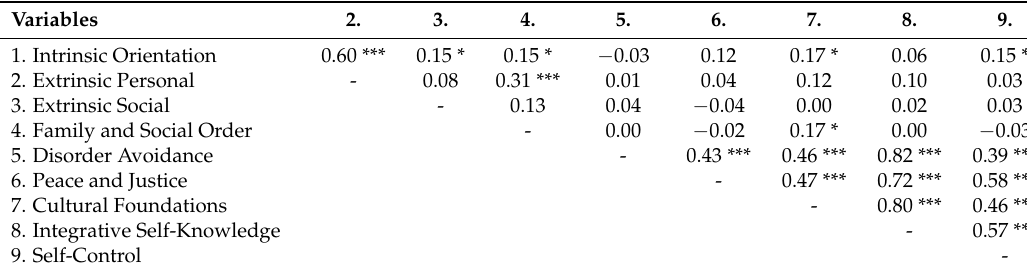
Table 1. Correlations among Religious Orientation, Extrinsic Cultural Religious Orientation, Integrative Self-Knowledge, and Self-Control Measures.